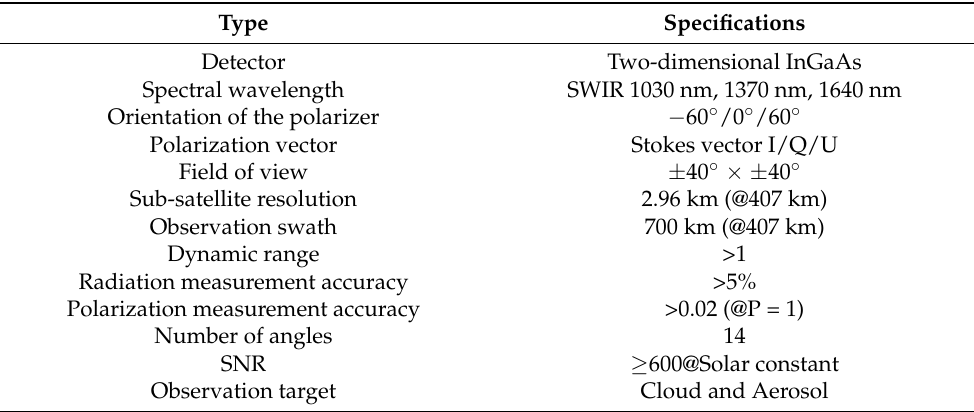
Table 2. Specifications of MAPI.